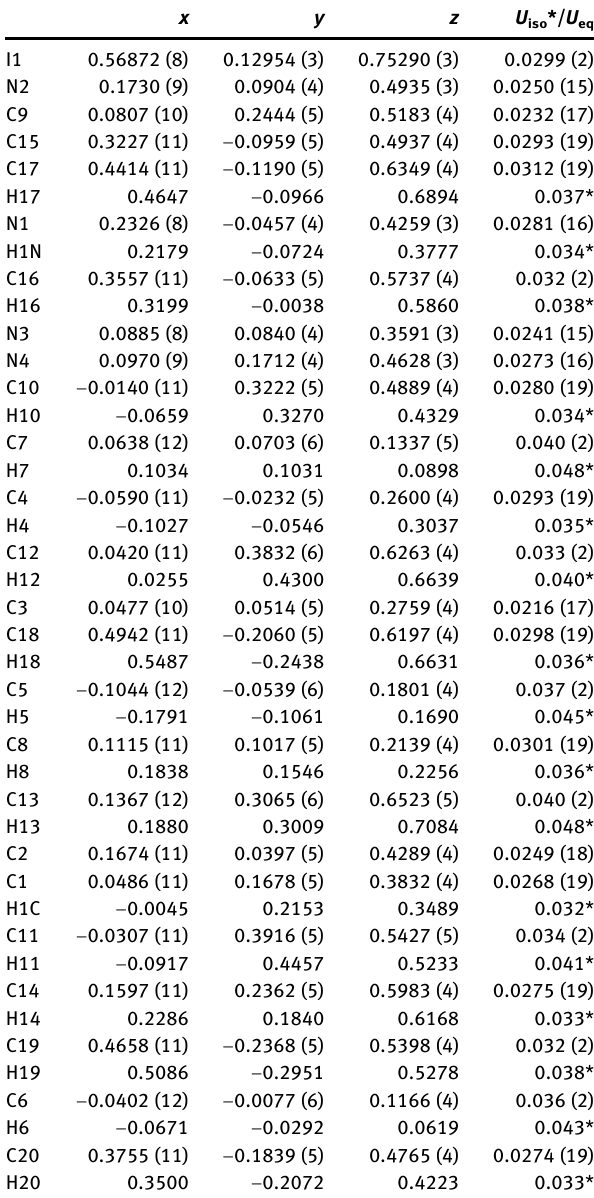
heterocyclic ring. The planarity of these rings allows intermolecular π – π stacking interactions to occur. The iodide ions are involved in short contacts of the types